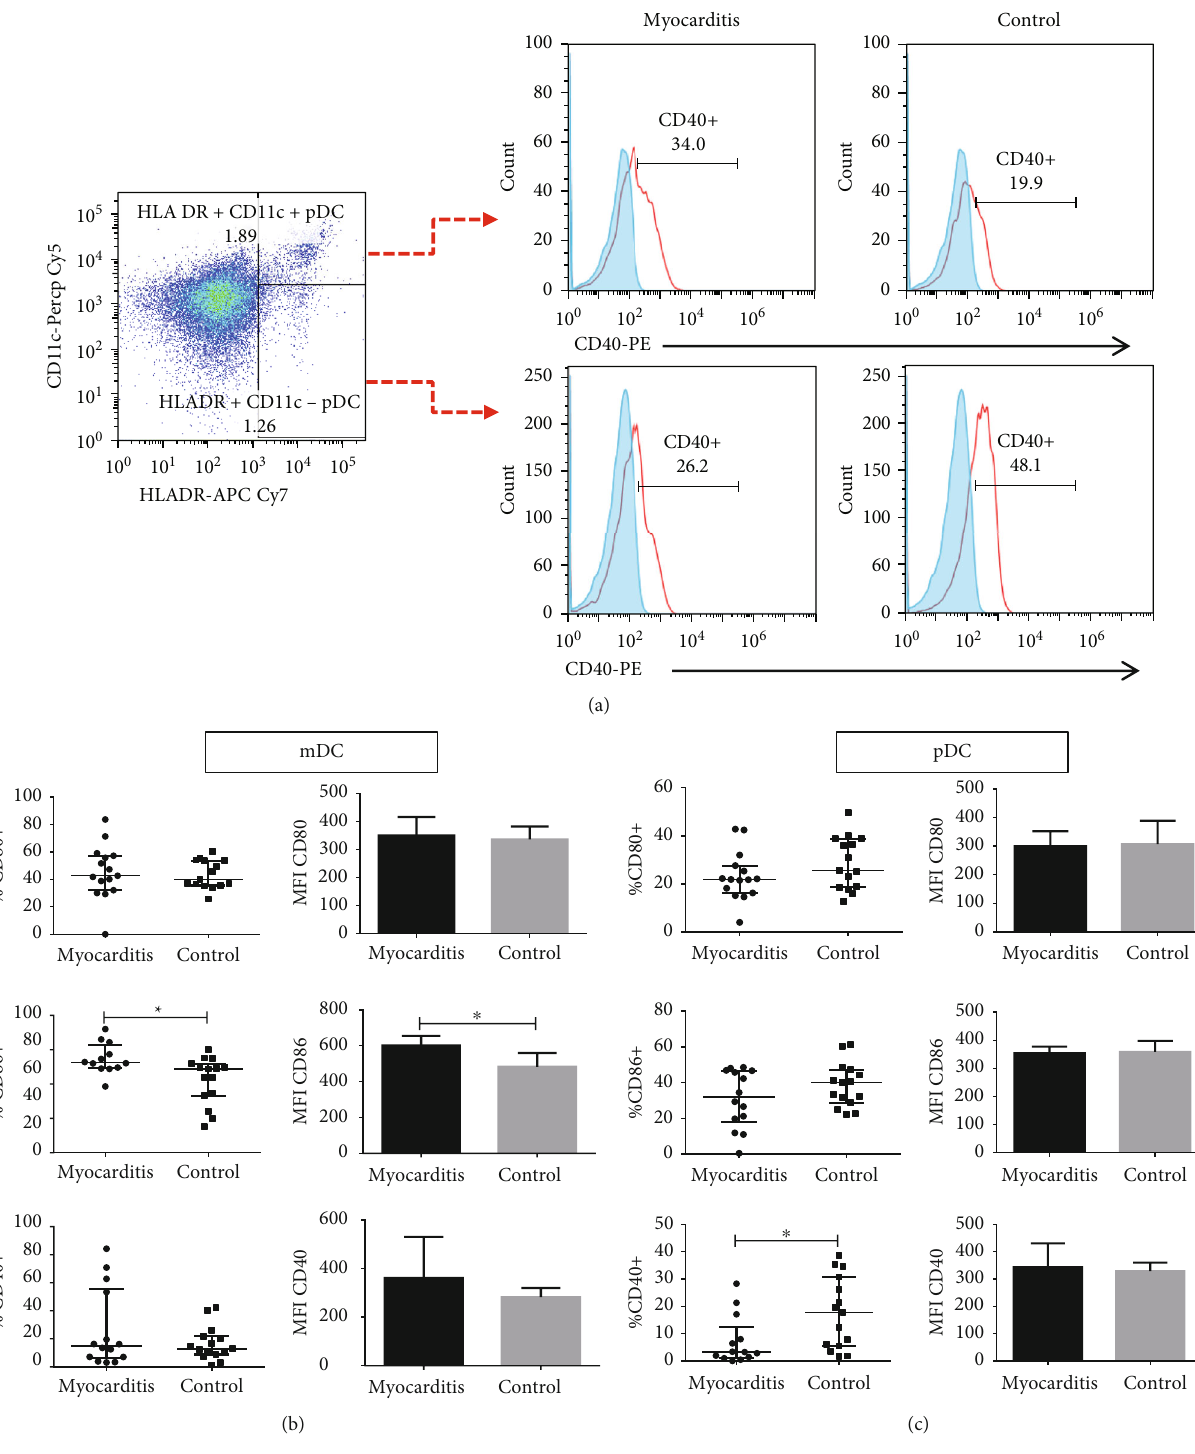
Figure 2: Percentages of costimulatory molecules in plasmacytoid and myeloid dendritic cells. PBMC from myocarditis and controls were immunostained, and cells were analyzed using fl ow cytometry. (a) Gating tree from lineage negative (LINneg), HLADR + CD11c + DCs (mDCs) additionally labeled for CD40+, CD80+ or CD86+, and (LINneg), HLADR+ CD11c − (pDCs) additionally labeled for CD40+, CD80+, or CD86+. (b) Percentages (left) and MFI (right) of costimulatory molecules in myeloid DCs. (c) Percentages (left) and MFI (right) of costimulatory molecules in plasmacytoid dendritic cells. ∗ p < 0 : 05 , ∗∗ p < 0 : 01